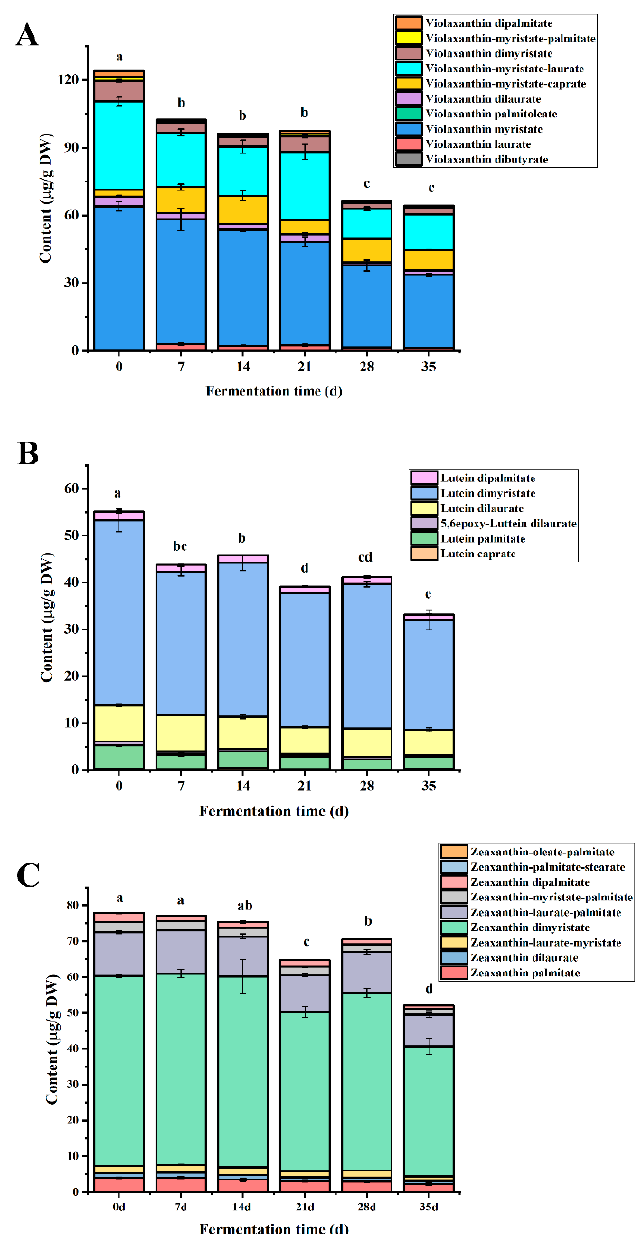
Figure 2. Changes in the content of ( A ) violaxanthin esters, ( B ) lutein esters and ( C ) zeaxanthin esters during fermentation. The different letters in the same figure indicate significantly different ( p < 0.05).